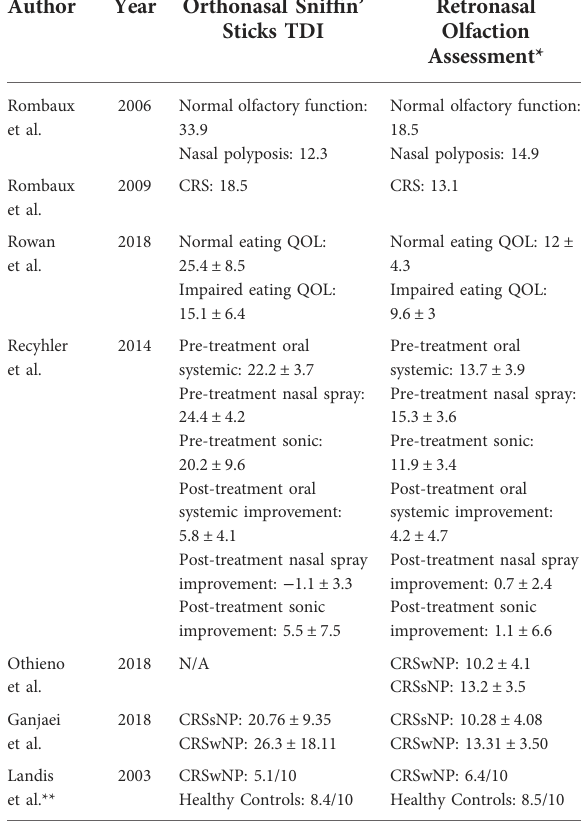
TABLE 3 Comparison between orthonasal and retronasal olfactory test scores in patients with